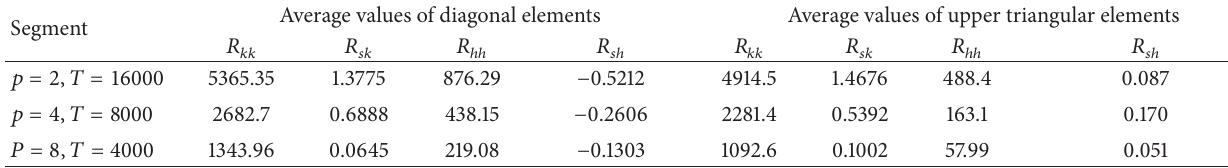
Table 1: Comparison of average values of diagonal elements and upper triangular elements for 𝑅 𝑠𝑘 , 𝑅 𝑘𝑘 ,𝑅 𝑠ℎ , and 𝑅 ℎℎ